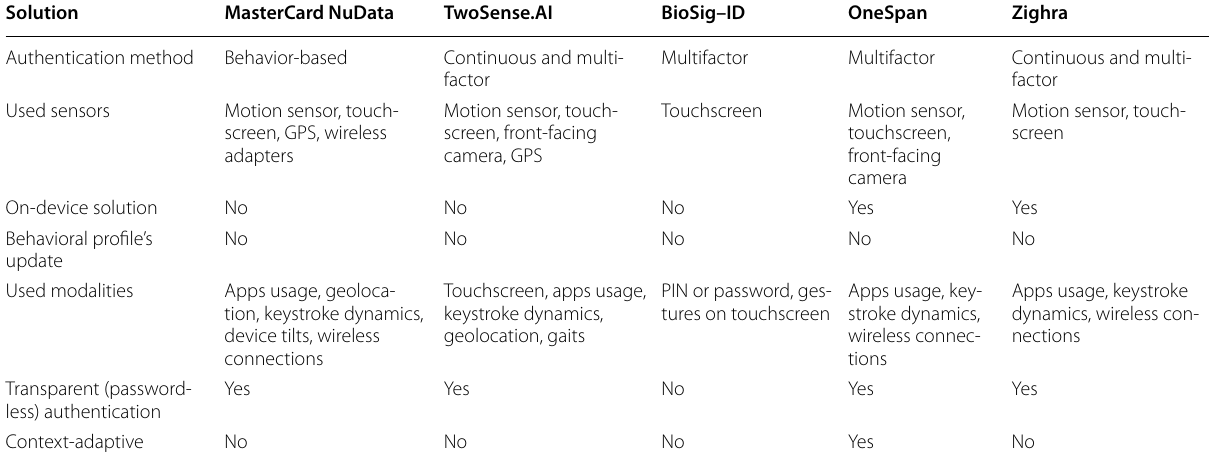
Table 1 Comparison of state-of-the-art commercial solutions in the domain of behavior-based user authentication on mobile devices